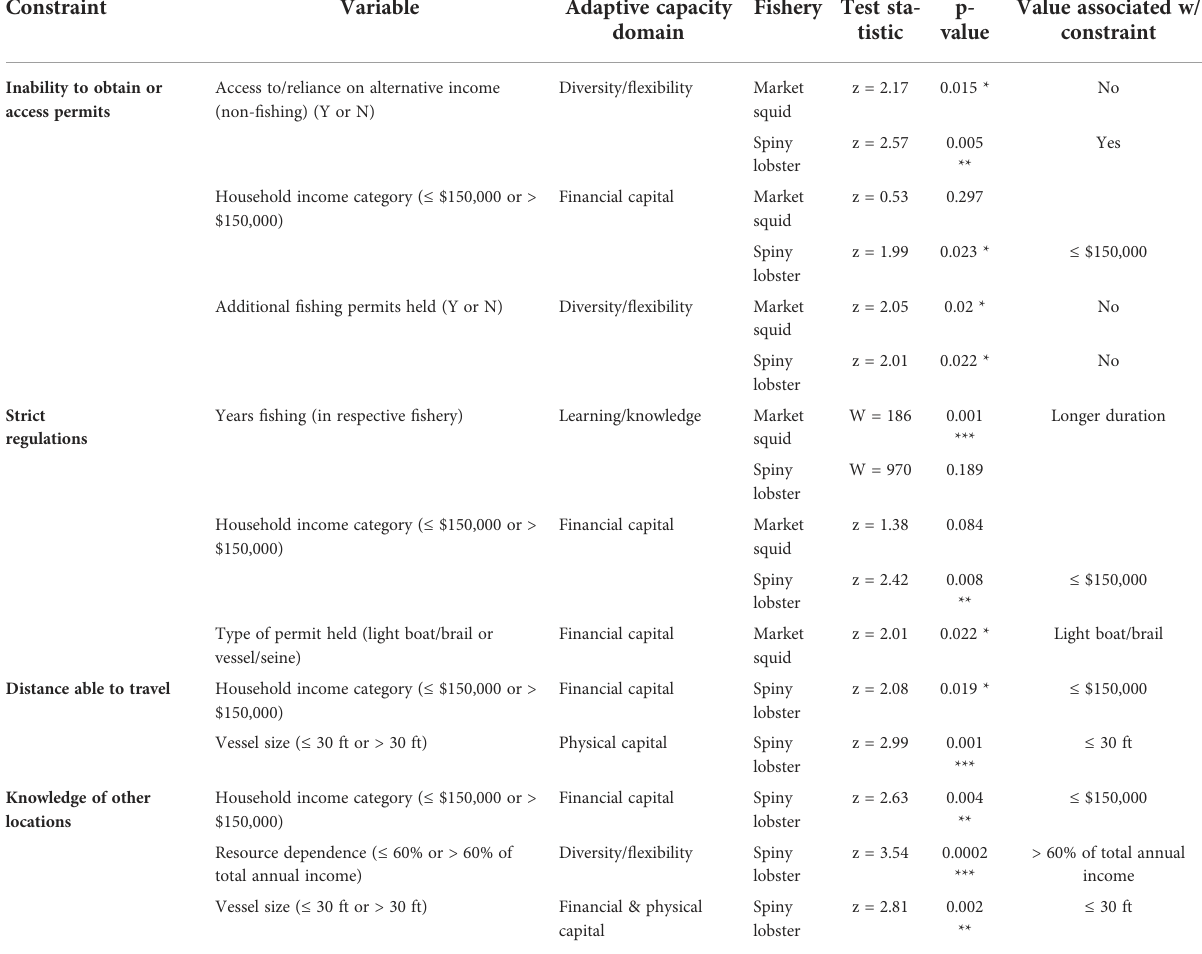
TABLE 1 Results from signi fi cance tests (two-proportion z-test and Wilcoxon signed rank test) showing factors associated with perceived constraints in each fi